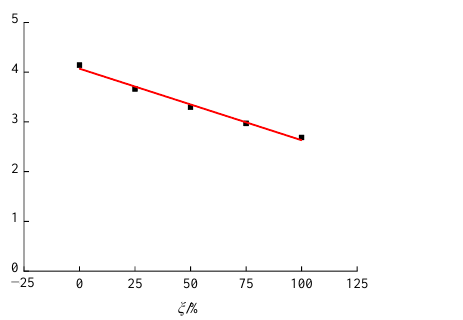
Figure 14. Relationship between the RA replacement rate and parameter e .